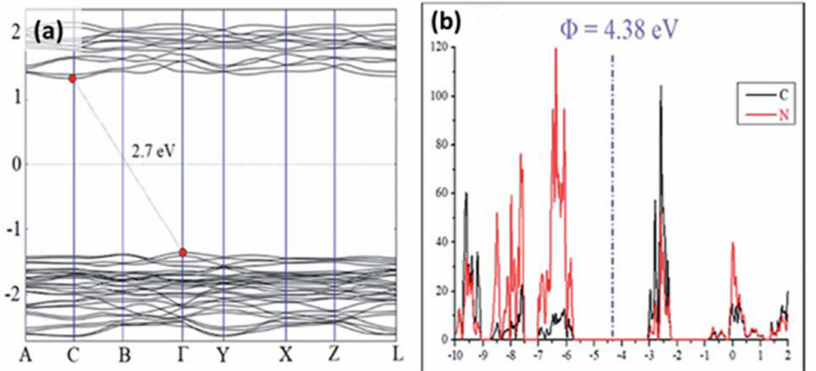
Figure 3. ( a ) g-C 3 N 4 band structure from density of states (DOS) calculations and ( b ) analysis of partial density of states (PDOS) comprising C and N orbitals. Reproduced with permission from [42], Copyright 2018,